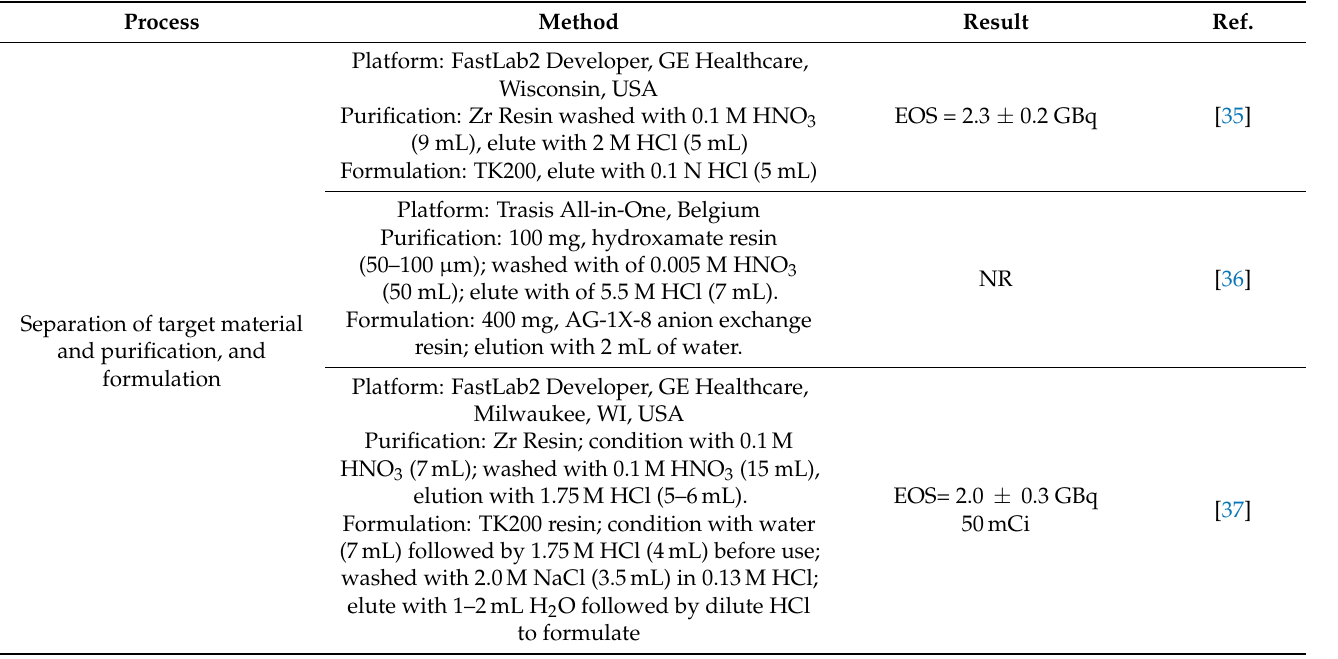
Table 7. Methods for separation of target material and purification and formulation of [ 68 Ga]GaCl 3 .